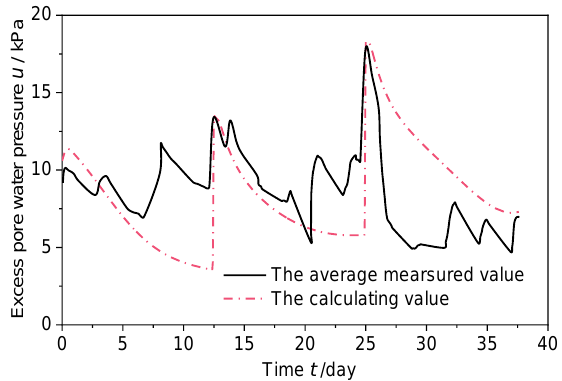
Figure 12. The temperature fitted curve.